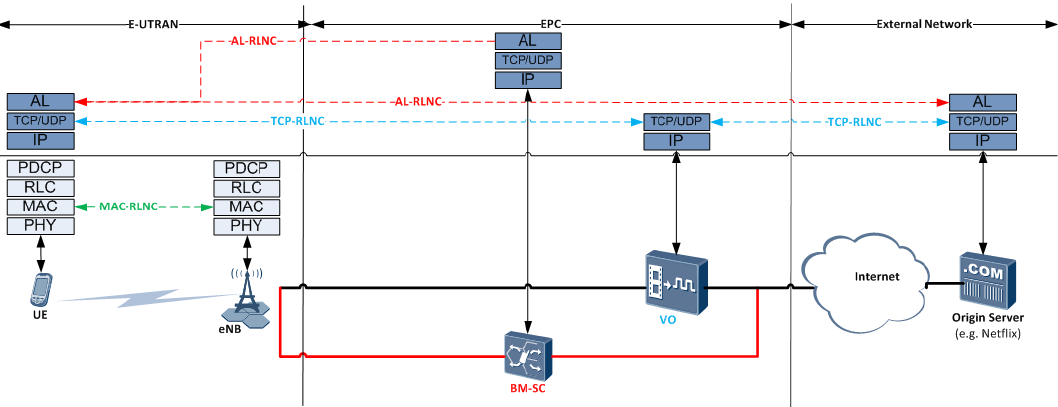
Figure 4. RLNC sublayer position options for mobile video